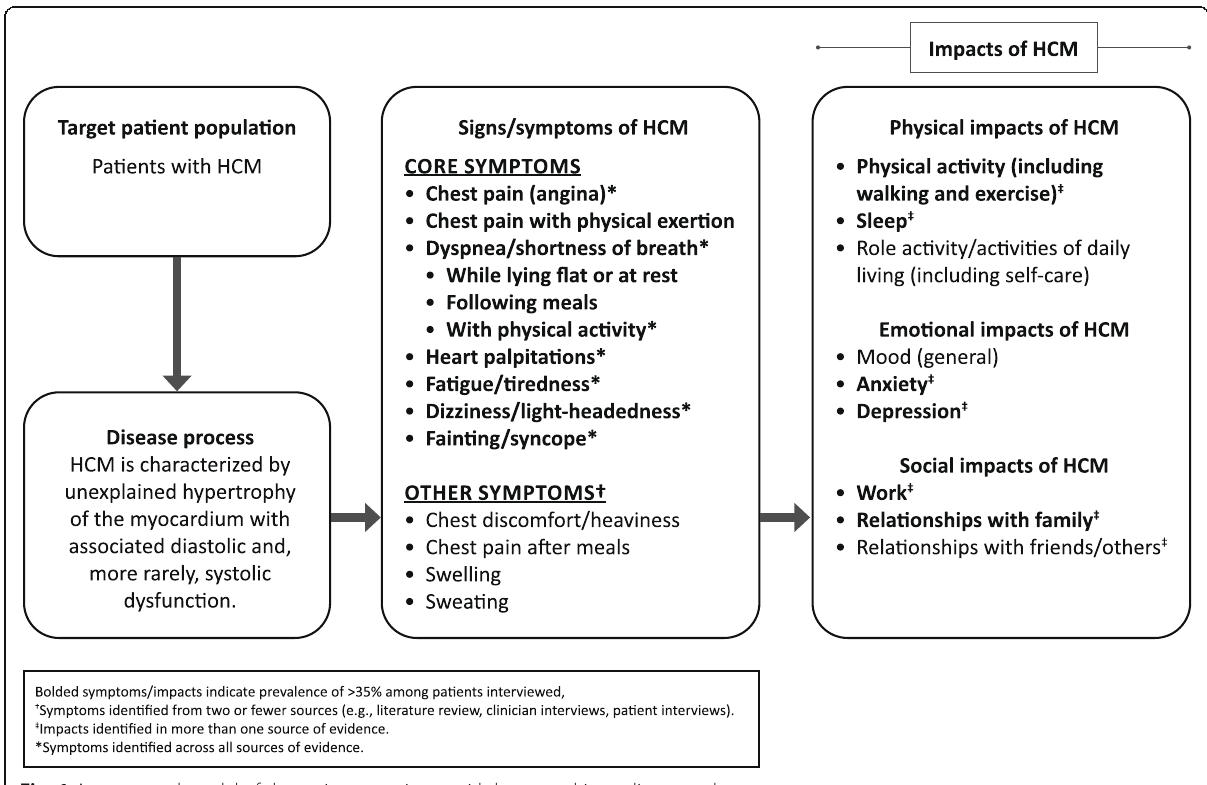
Fig. 1 A conceptual model of the patient experience with hypertrophic